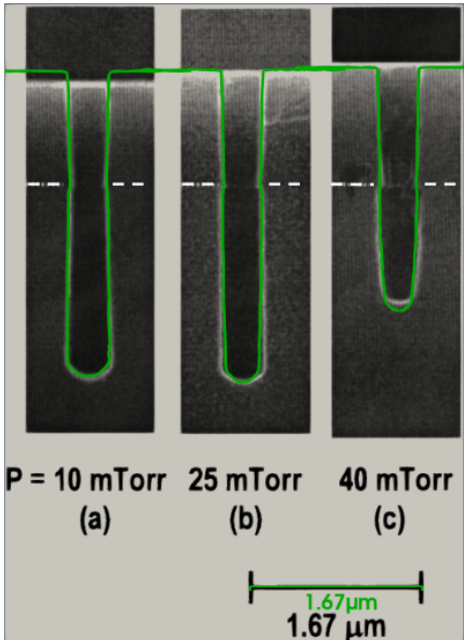
Figure 4. Diagonal slices through a 3D-simulated (green) and experimental (black) cylindrical hole profiles at increasing chamber pressures: ( a ) 10mTorr; ( b ) 25mTorr; ( c ) 40mTorr. The oxide mask–Si interface is depicted with a white dashed line. (Reprinted with permission from[25]). Copyright 2005, American Vacuum